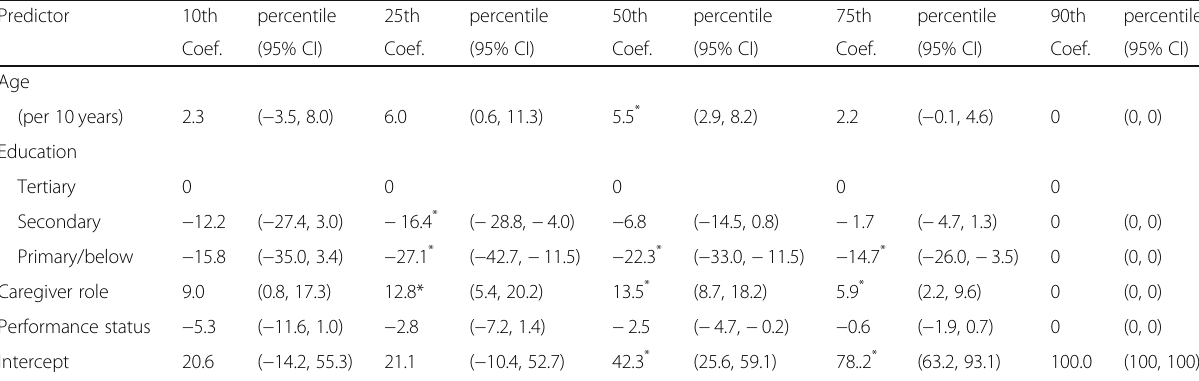
Table 8 Percentiles of QOL Financial Well-being score, final model Predictor 10th percentile